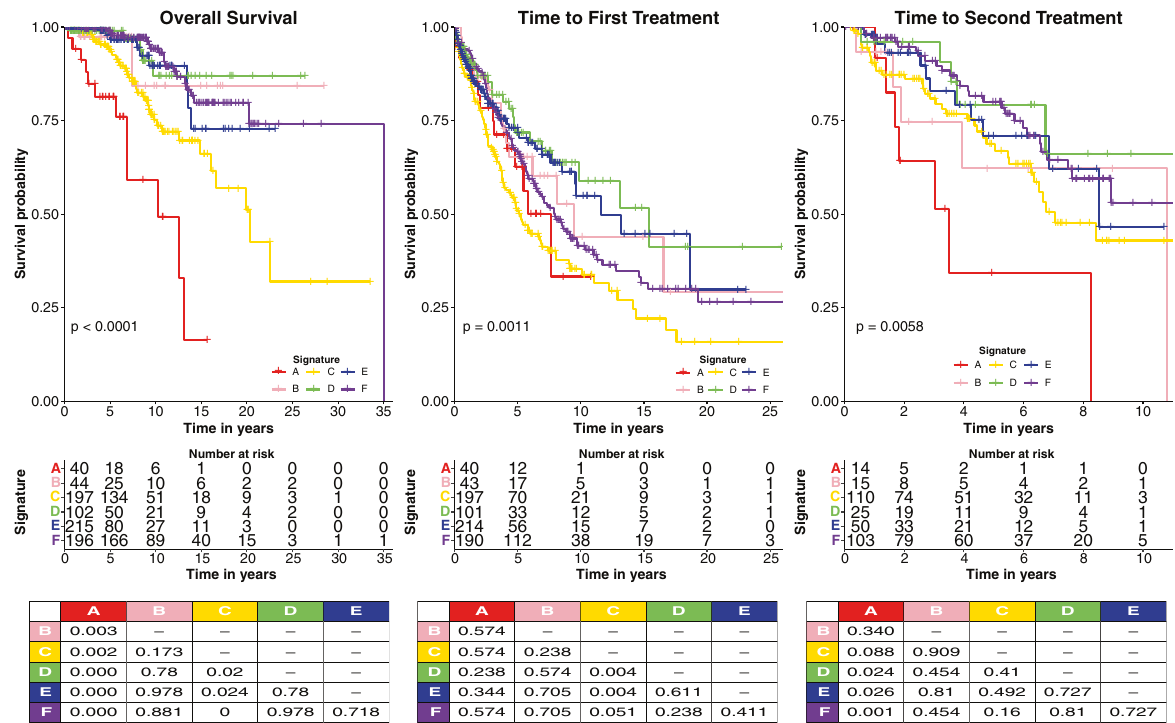
Fig. 3 Outcomes of CLL signature groups. Kaplan – Meier plots of OS (left), TTFT (middle), and TTST (right) of CLL signature groups are shown. Overall log-rank p -values (bottom left of each fi gure), and BH corrected individual comparison p -values are shown (tables at the bottom). Signature groups A and C consistently have the lowest OS and TTFT compared to other group (Supplementary Fig. S16 top row), with small numbers hindering analysis of the very high-risk IPI group. Similar to the reverse analysis (Supplementary Fig. S15) the two scoring systems were complimentary for TTFT prognosis with protein signature group separating IPI low, high, and very high (Supplementary Fig. S16 bottom row). As for mutations, we observed that signature groups prognosticated within 17p deletion patients for OS and TTFT. Within those with 11q abnormalities, those with Sig C and F had worse survival than the other four signatures, with very small numbers of Sig A and B complicating the analysis (Supplementary Fig. S17). Proteomic SG membership was therefore additive to the prognostic information from IGHV-mutation status, 17p deletions, and CLL-IPI classi fi cation.